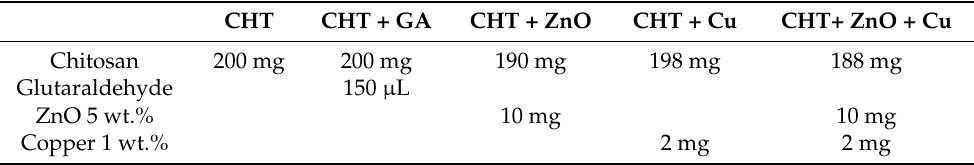
Table 1. Composition of chitosan and chitosan composite films. CHT CHT + GA CHT + ZnO CHT + Cu CHT+ ZnO + Cu Chitosan 200 mg 200